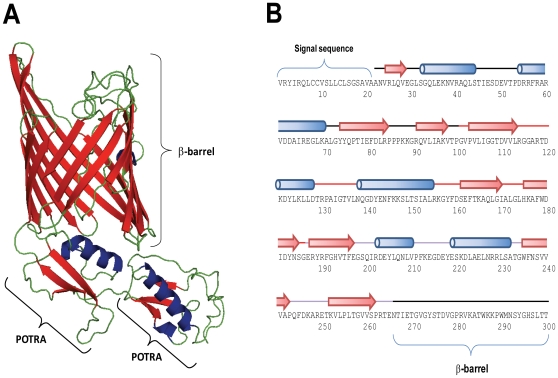
Structural predictions of YtfM.(A) The conserved TpsB homologue YtfM was modelled using SWISS-MODEL and is predicted to form an outer membrane β-barrel structure with two POTRA domains extending into the periplasm. The model was based on the crystal structure of FhaC, the well-characterised TpsB translocator of B. pertussis filamentous haemagglutinin; the first POTRA domain could not be modelled. (B) Secondary structure predictions of the N-terminal domain of YtfM using PsiPred predicts the presence of three POTRA domains based on the structural motif β–α–α–β–β; the POTRA domains are highlighted by red, green and cyan lines. The amino acid sequence corresponding to the β-barrel is truncated. Arrows corresponds to β-strands whereas α-helices are depicted by cylinders.